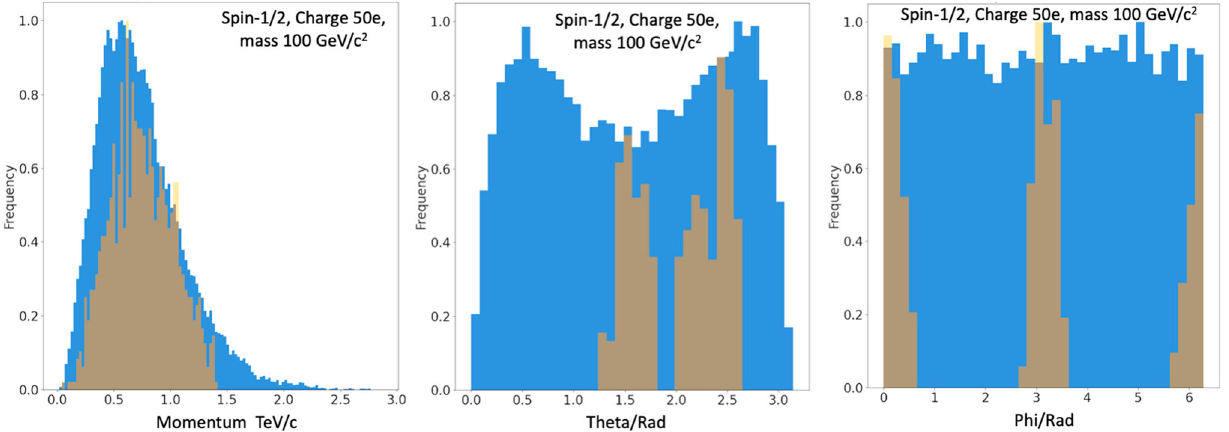
Fig. 18 The momentum, theta and phi angle distribution for spin-1/2 HECOs of mass 100 GeV/c 2 and electric charge 50 e , produced via the DY process via virtual photon and Z 0 exchange. In each case, 60K events were originally generated. The plots are normalized to the max-